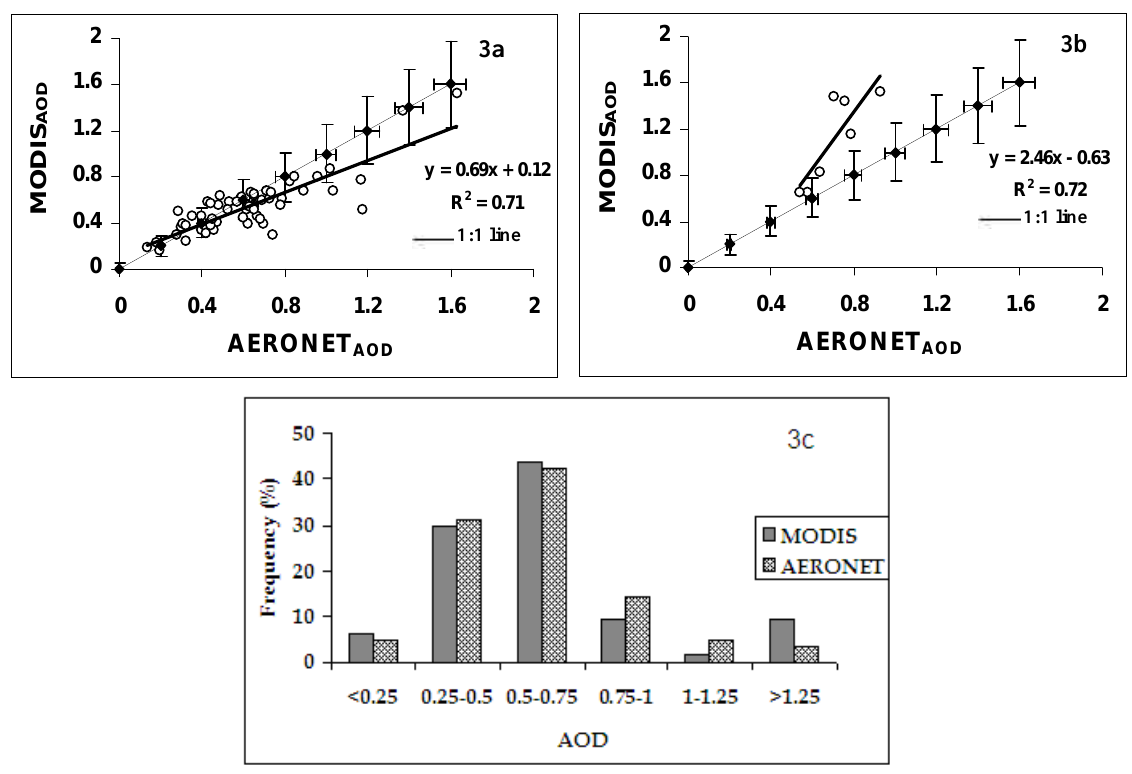
Fig. 3. Scatter plot between AOD derived from MODIS and AERONET in 2004 during (a) non-dust loading period and (b) dust-loading period and (c) frequency distribution of AOD derived from AERONET and MODIS. The error bars in Figs. 3a and b indicate the range of MODIS expected accuracy ( ± 0.05 ± 0.2 τ a ) from the 1:1 line (along Y-axis) and the uncertainty of AERONET measurements (along